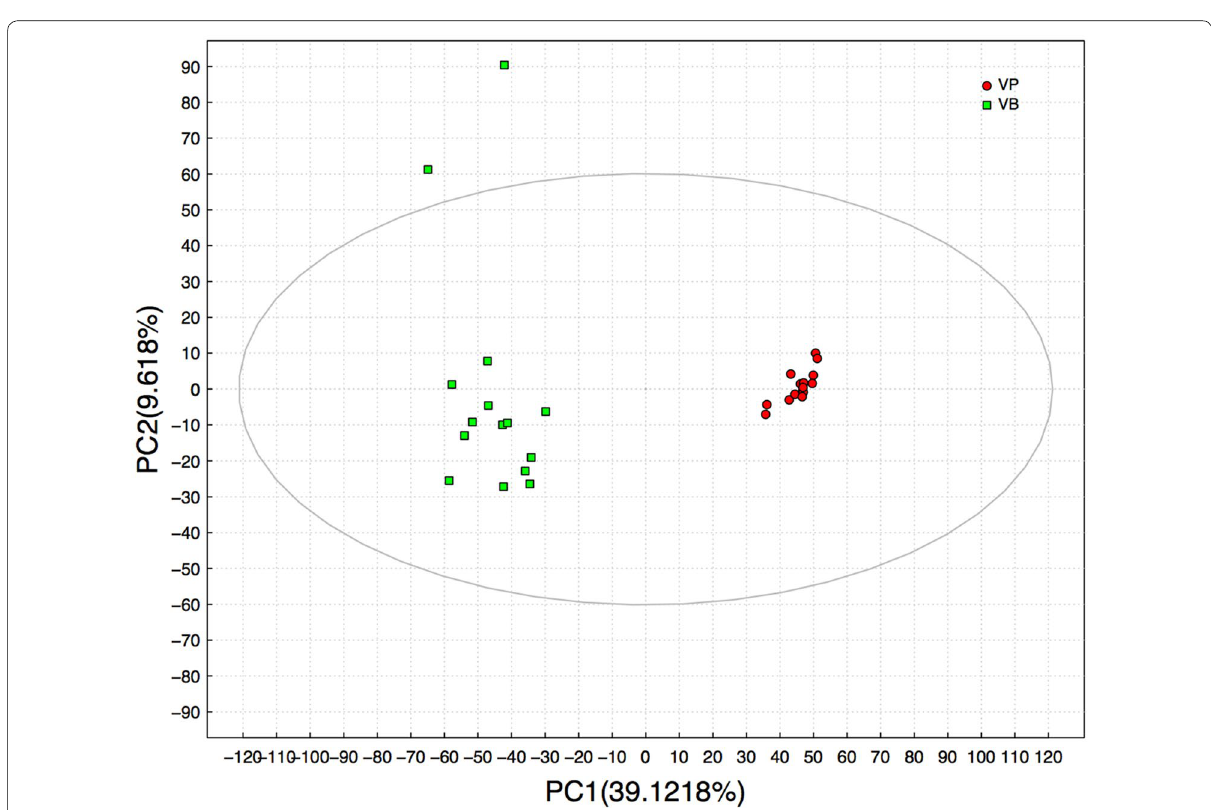
Fig. 3 PCA score separating vanilla pods and vanilla beans away from each other ( VP vanilla pods, VB vanilla